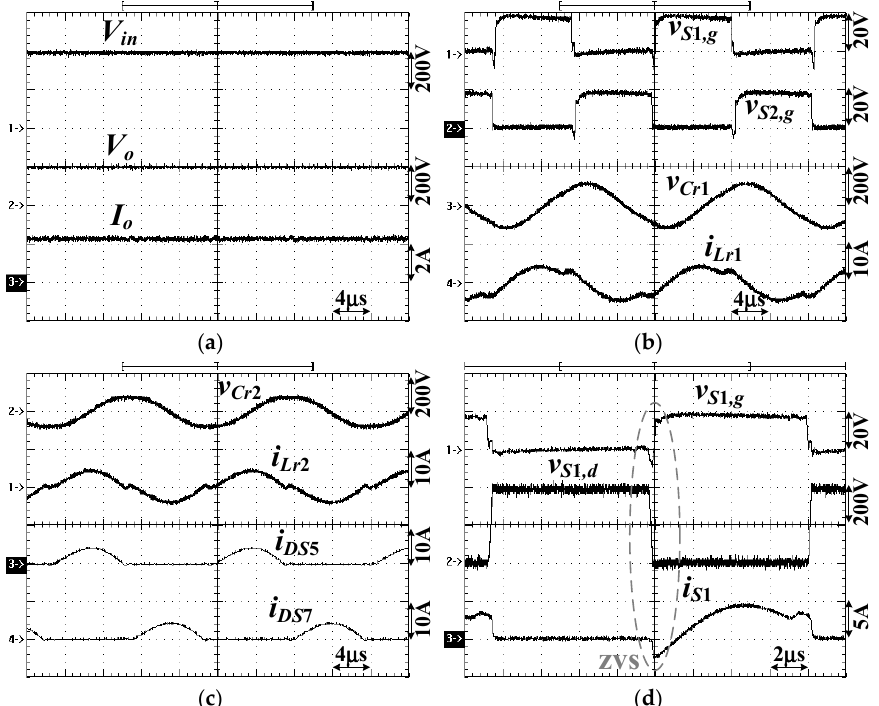
Figure 10. Measured waveforms ( a ) V o and I o under constant current (CC) mode and constant volt- age (CV) mode control; ( b ) V o , v Sac , and v S 3, g .